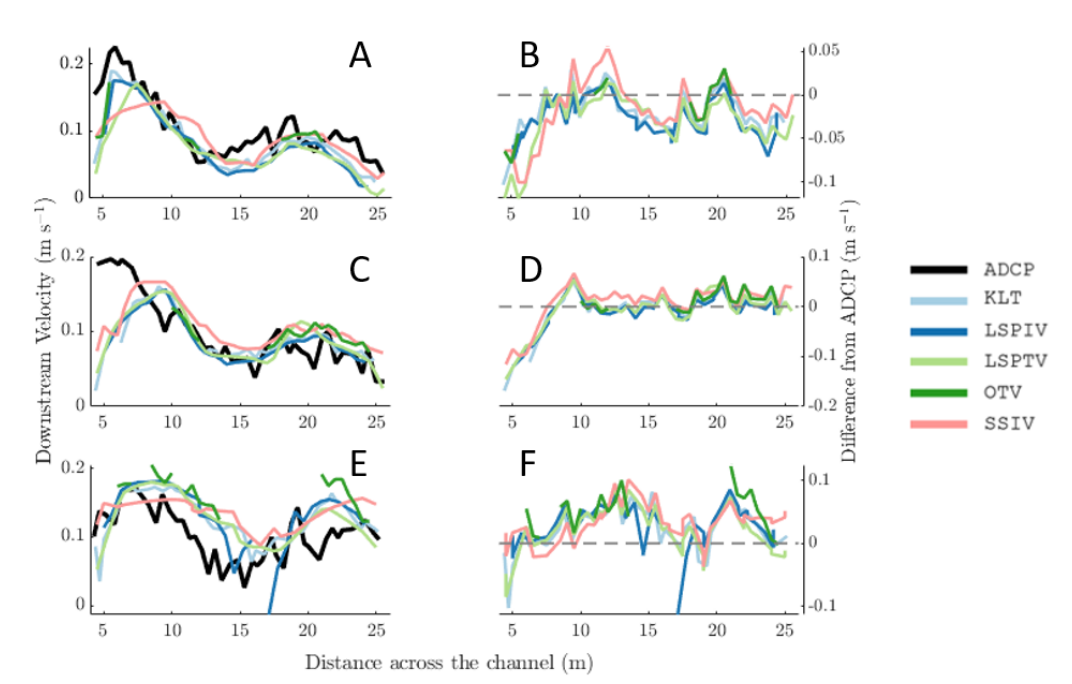
Figure 8. Cross-sectional analysis of Video A processed with all algorithms against the ADCP data. The left panels represent three different cross-sections ( A = S1, C = S2, and E = S3), the right panels represent the difference from the ADCP of the three cross-sections ( B = S1, D = S2, and F = S3). The distance across the channel relates to the y co-ordinates in Figures 2, 4 and 6. 5 m is the right bank, and 25 m is the left